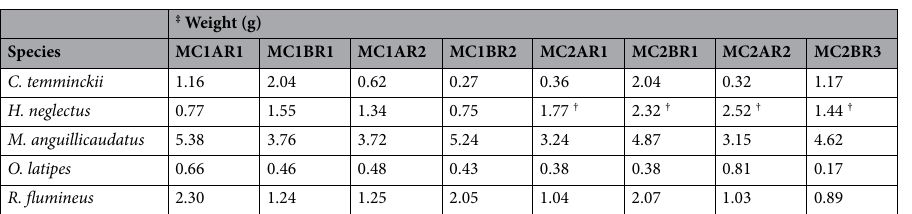
Table 2. Composition and weight of the species used in the aquaria. † Sum of three individuals. ‡ The weight was measured at the end of the experiment (day